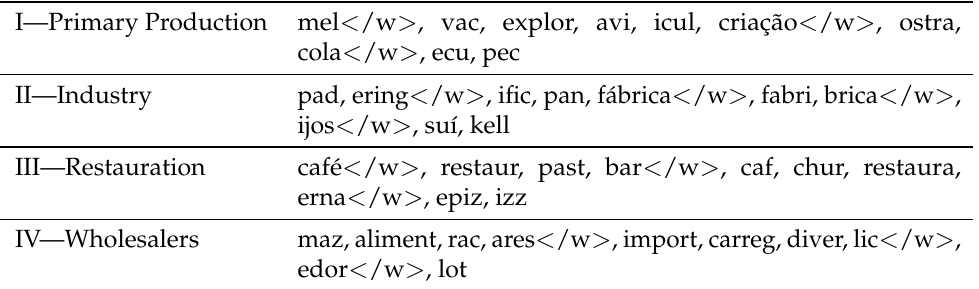
Table 21. Top-10 features for economic activity prediction using XLMTokenizer with